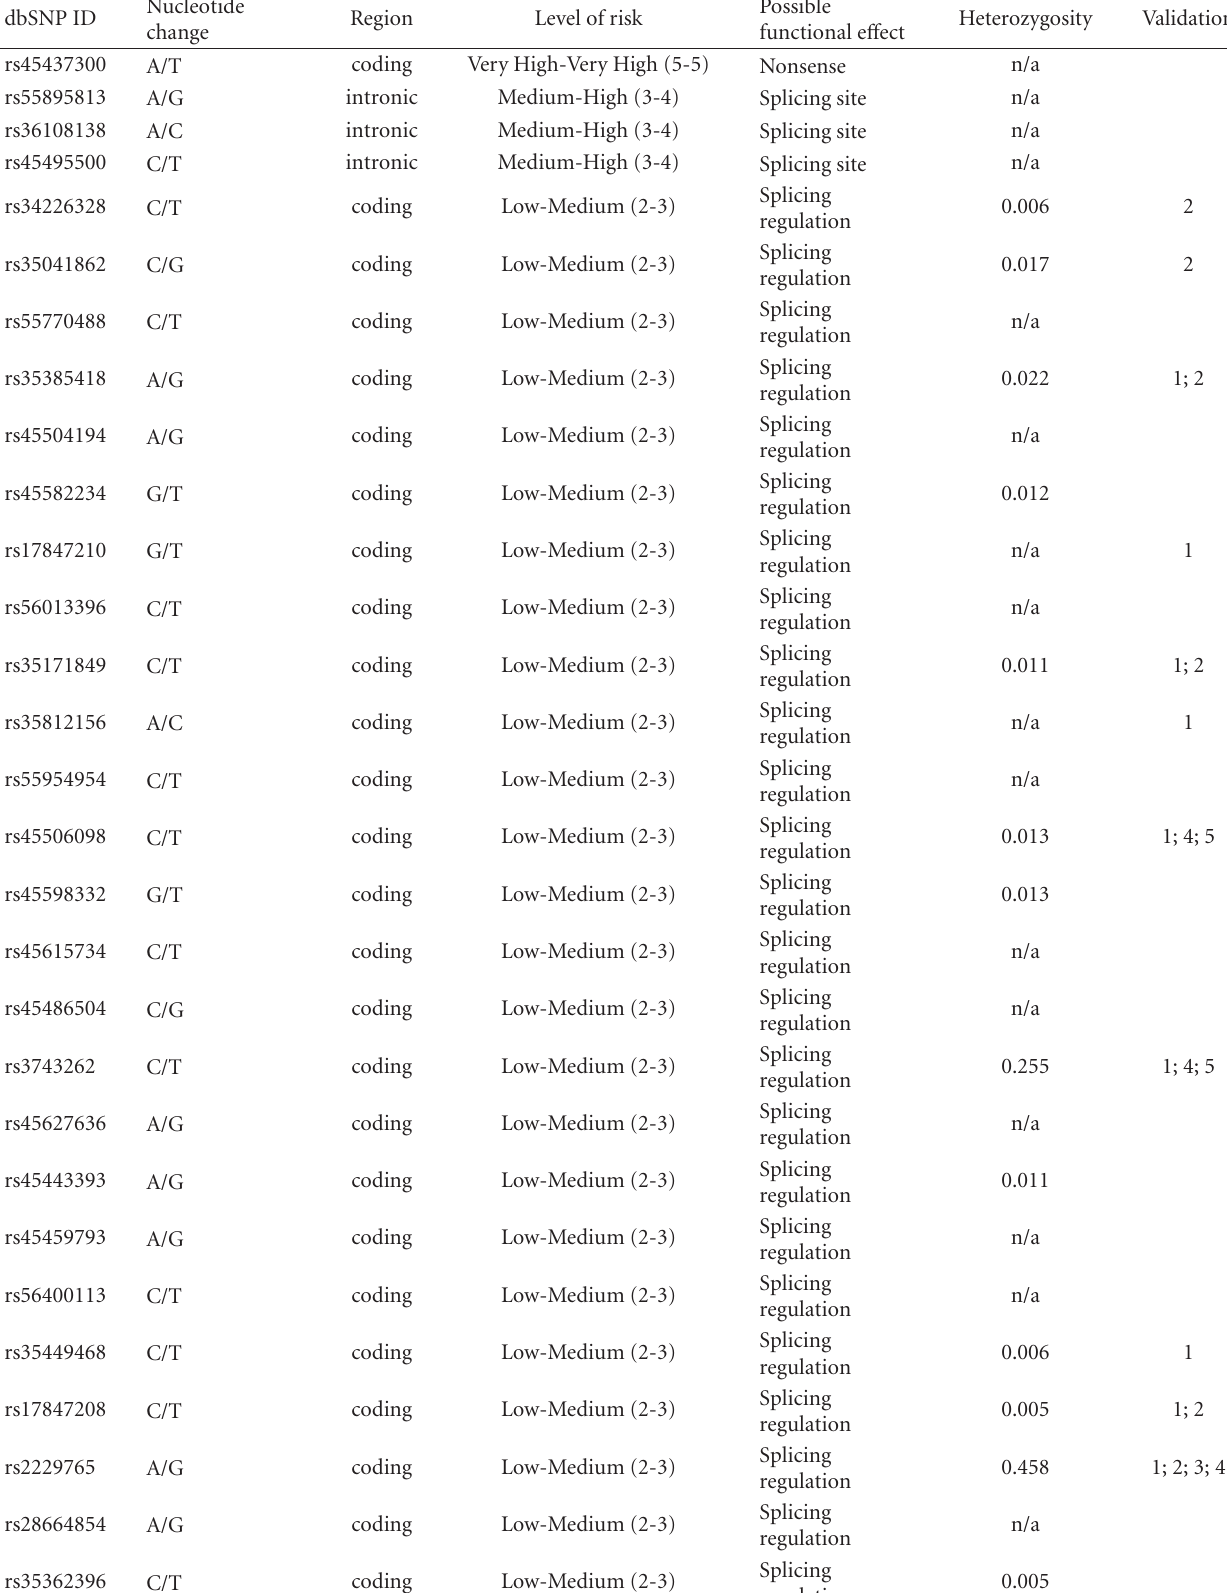
Table 2: List of SNPs predicted to be functionally significant by